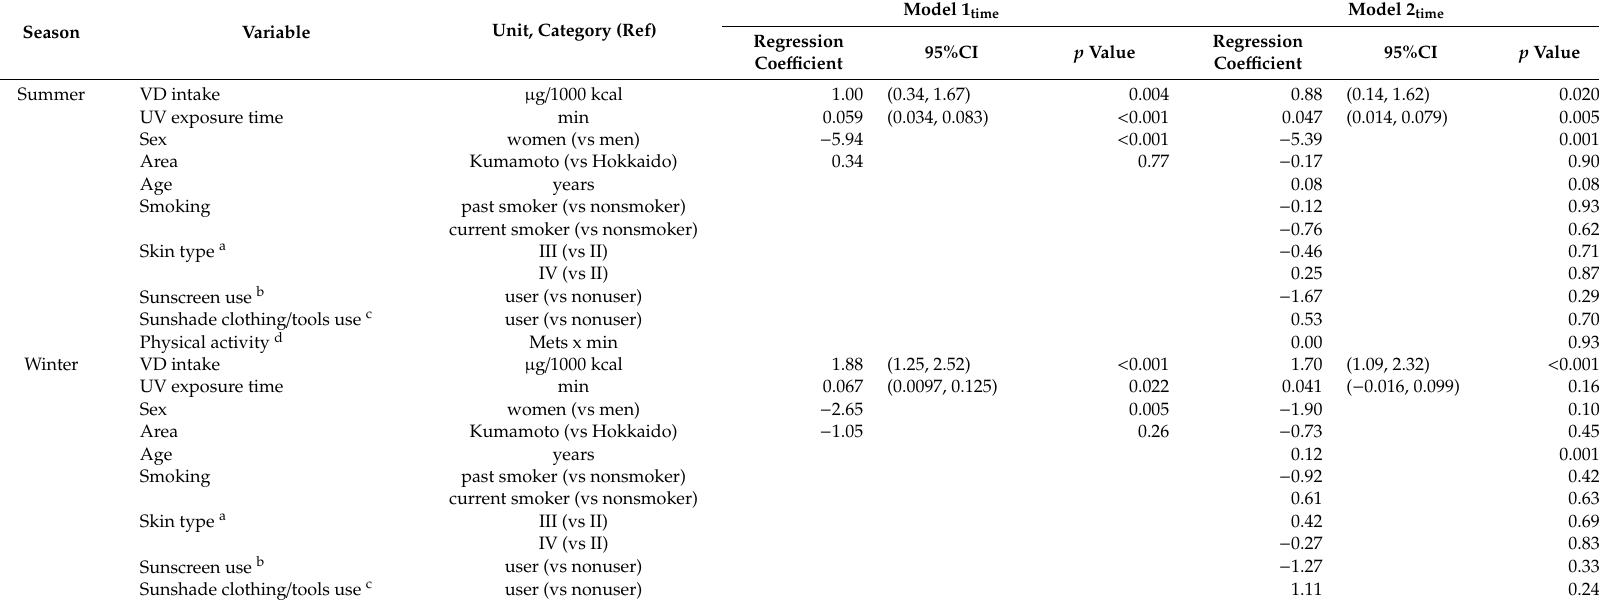
Table 2. Relationship between dietary vitamin D intake, UV exposure time and serum 25(OH)D 3 concentration by season among Japanese adults ( n =